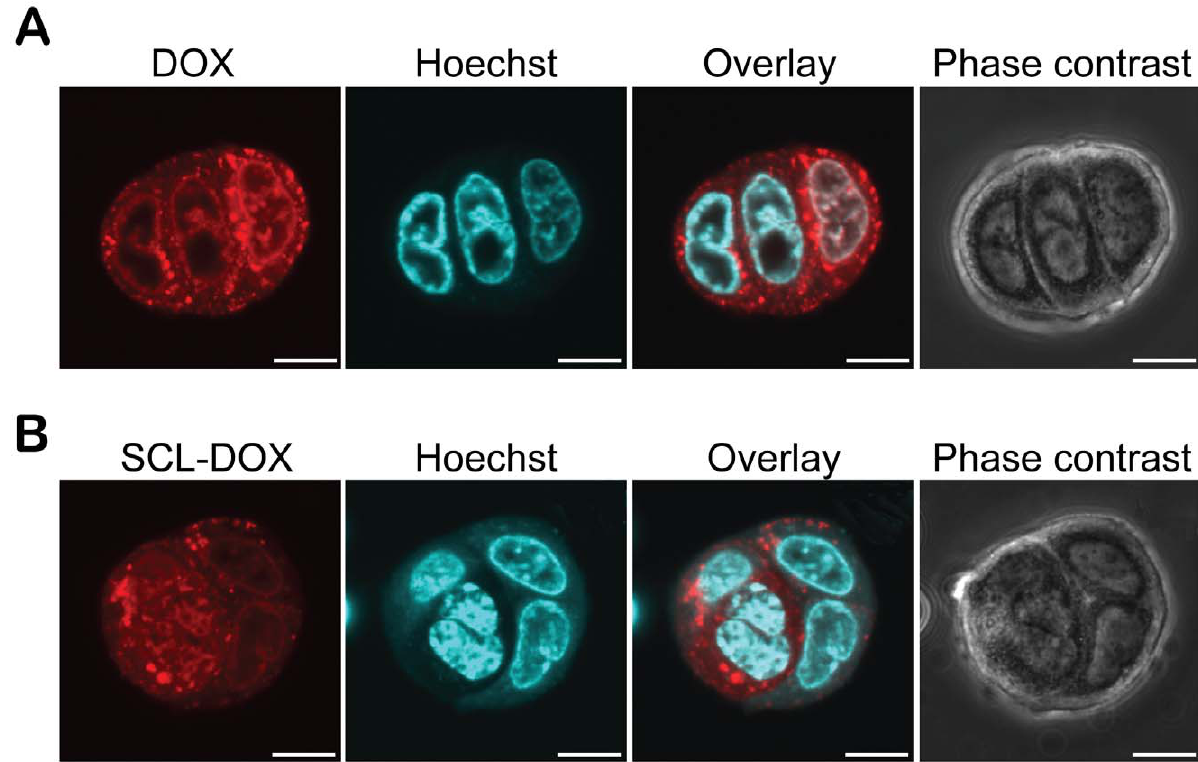
Figure 1. Intracellular uptake of SCL-DOX in HT-29 cells. HT-29 cells were incubated with 2 m g/mL free DOX or equivalent SCL-DOX for 24 h. Following two washes with PBS, cells were imaged with a confocal fluorescence microscope. ( A ) Cells treated with free DOX. ( B ) Cells treated with SLC-DOX. Red: fluorescence from DOX; blue: nuclei stained with Hoechst 33342. Scale bars: 10 m m. Table 2. In our study, the clearance rate of DOX encapsulated by SCL-DOX (1.39 L/h/kg) was significantly lower than that of DOX solution (2.68 L/h/kg, p , 0.01), suggesting a different rate of clearance of SCL-DOX compared to free drug. Moreover, the area under the plasma concentration-time curves during the study period (AUC 0–48 h ) of DOX delivered through SCL was 2.37-fold higher than free DOX ( p , 0.01). Thus, DOX could display a significantly reduced clearance rate as well as enhanced bioavailability when administered entrapped in SCL.